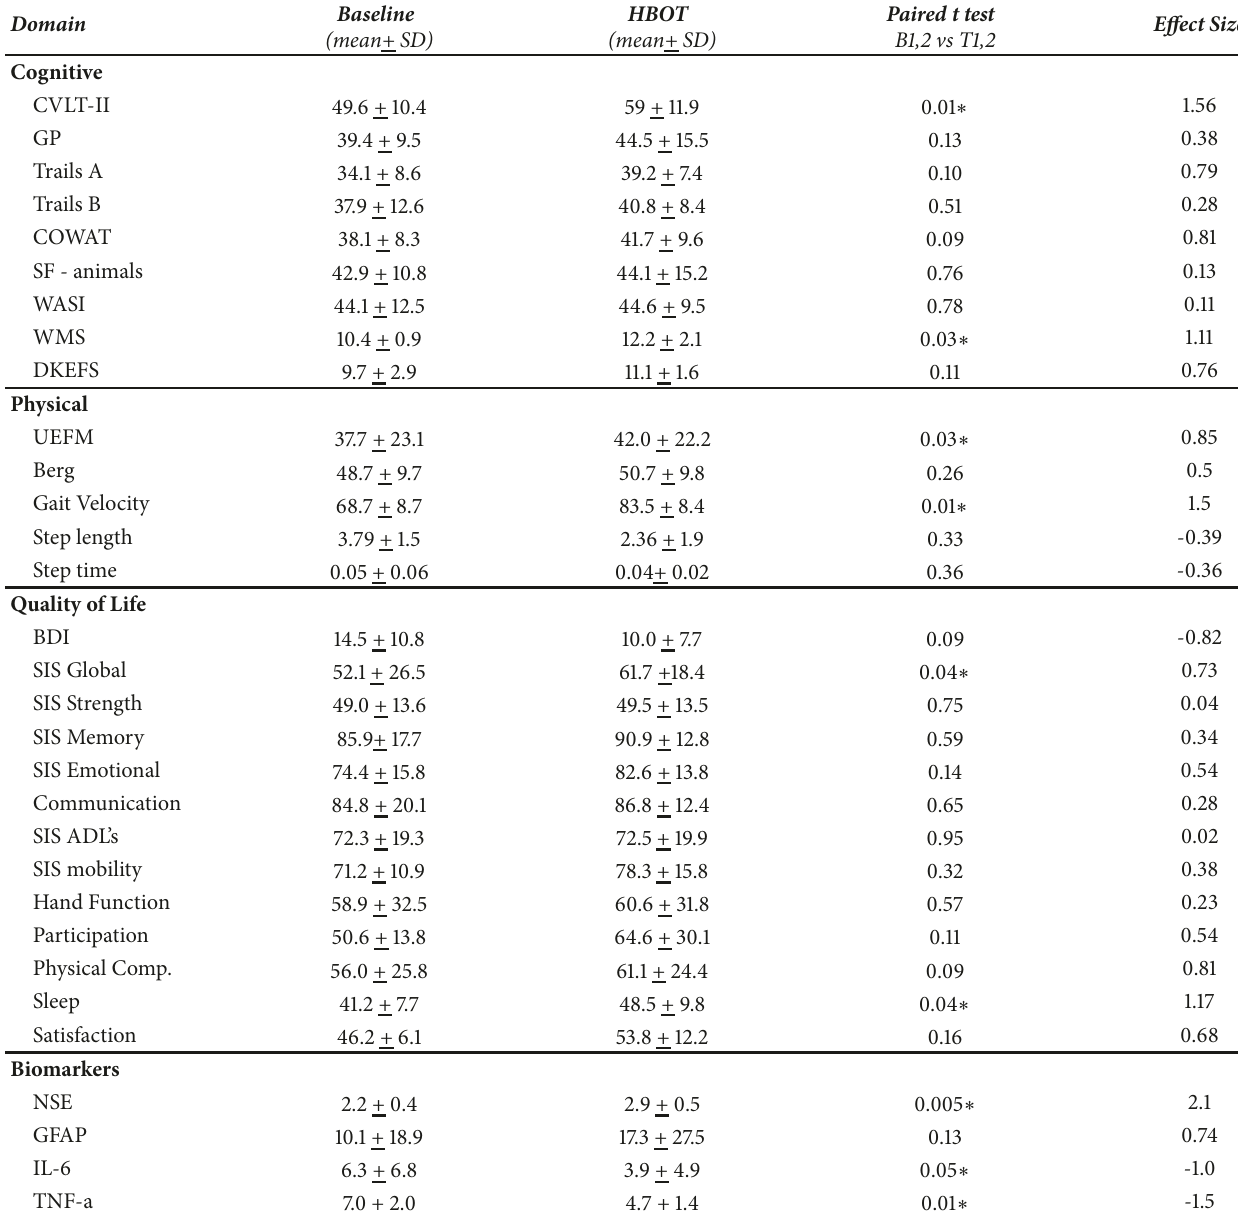
Table 2: Effect of HBOT on functional impairments: means and effect